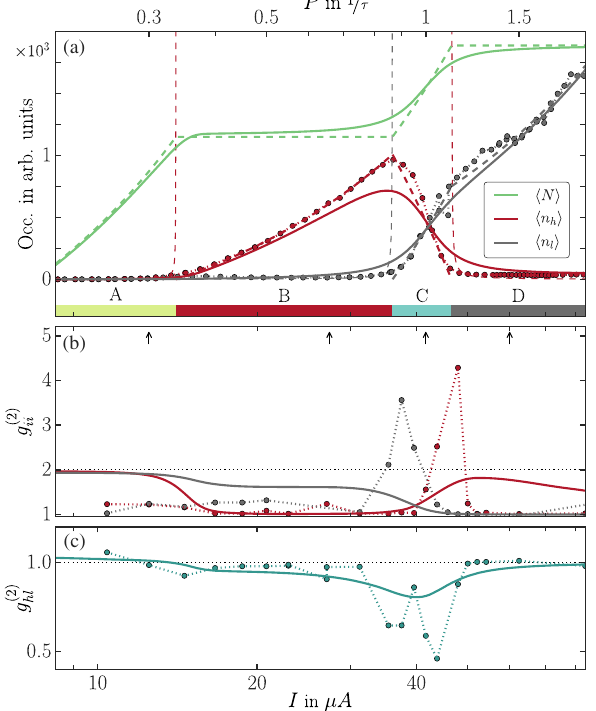
FIG. 8. Calculated input-output characteristics and fluctuation for both modes in the presence of spontaneous transitions between the modes, s ¼ 1 . The fluctuations are restricted to 2 Þ ≤ 2 . All parameters are chosen as in Fig. values g ð ii